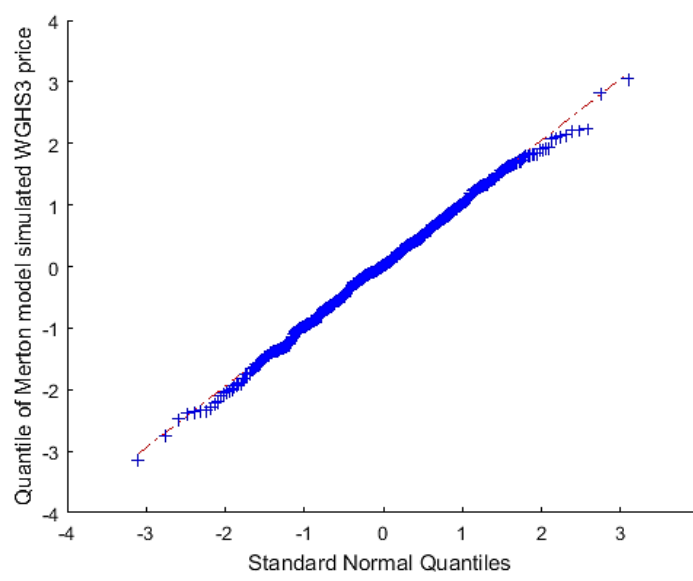
Figure 8. The Q-Q plot of Merton’s model simulated WHGS3 sesame price.